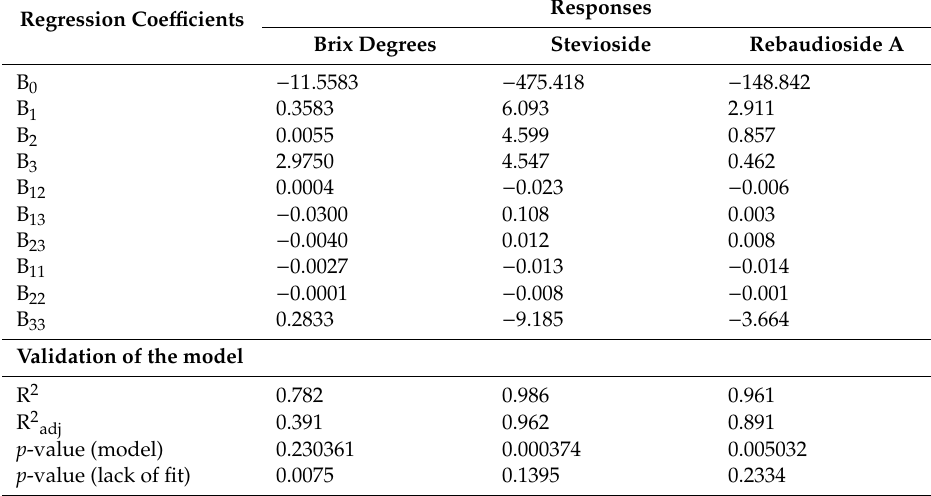
Table 4. Regression coe ffi cients and analysis of variance of the model obtained by response surface methodology